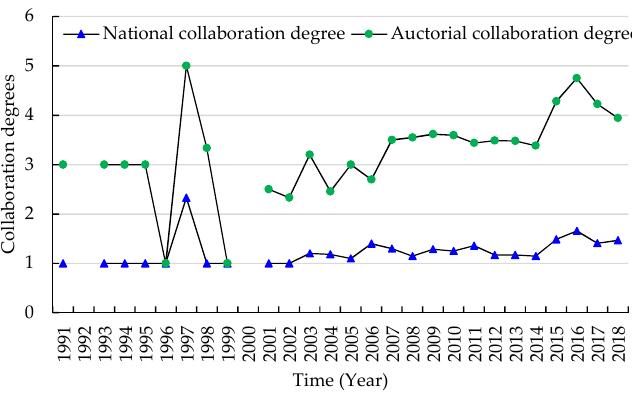
Figure 6. National and auctorial collaboration degrees.